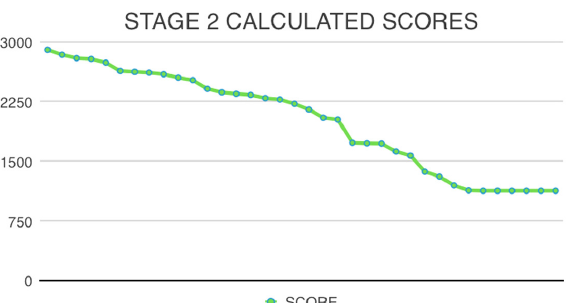
Figure 5. The IoU scores of the 36 teams.